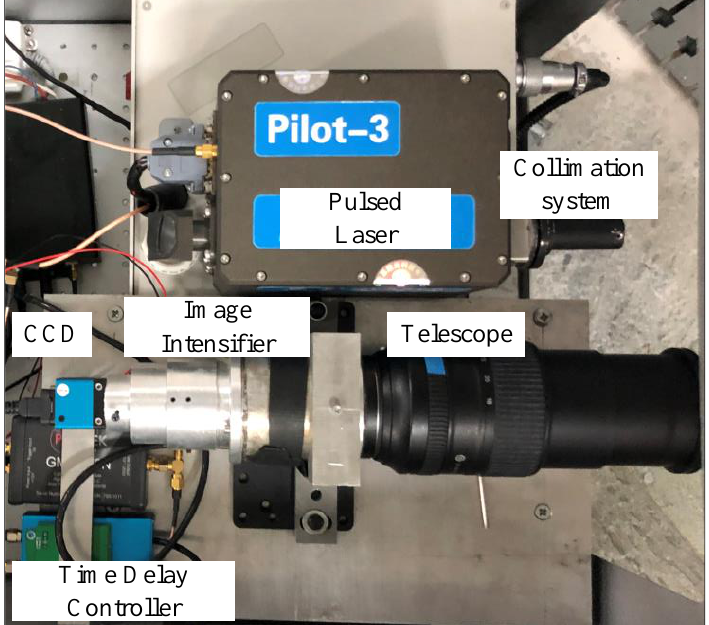
Figure 2: Optical image of self-developed underwater imaging Figure 2. Picture of self-developed underwater imaging flash LiDAR system in this work. flash lidar system used in this work. Two flat panels were used as targets for the measurements, as shown in Figure 3. The first target is a rectangle that is a 40 cm long and 30 cm width, which is 25.7 m away from the LiDAR system. The second target is circular shaped with a diameter of 40 cm, which is 70 cm further away from the first target. The angle between the rectangular target plane and the laser transmission direction is 41.4 ◦ . In the experiment, the used range-gate width is 20 ns and the delay step is 1 ns.